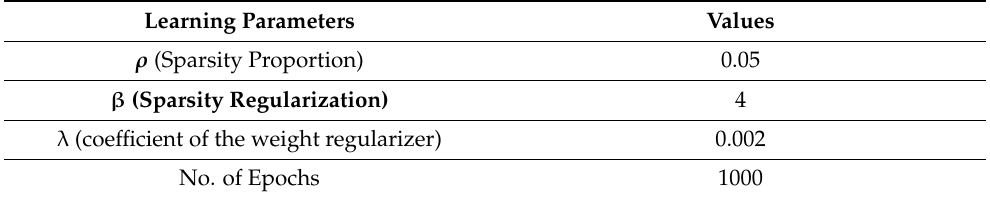
Table 3. The values for the learning parameters used in the training of Autoencoder 1, and Autoen- coder 2 in the stacked deep